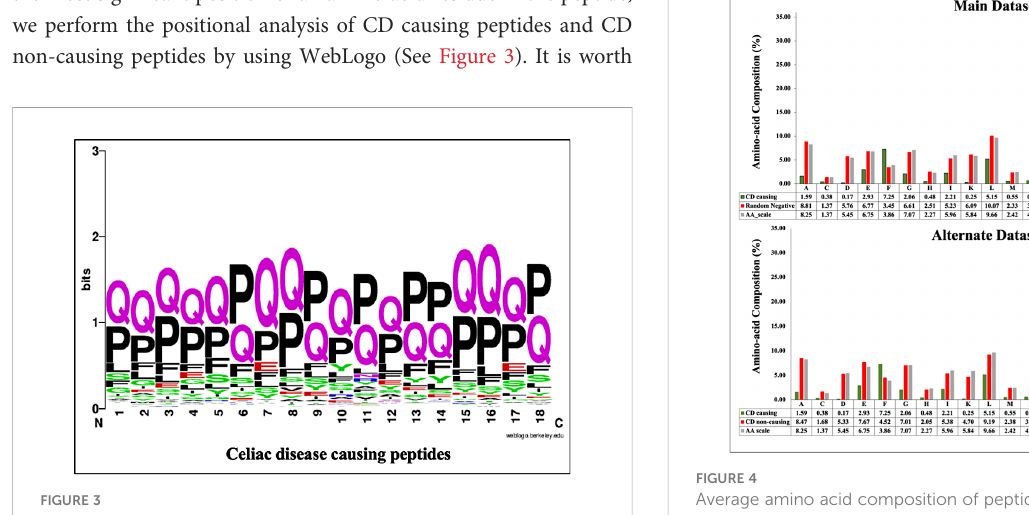
FIGURE 4 Average amino acid composition of peptides in main dataset and alternate